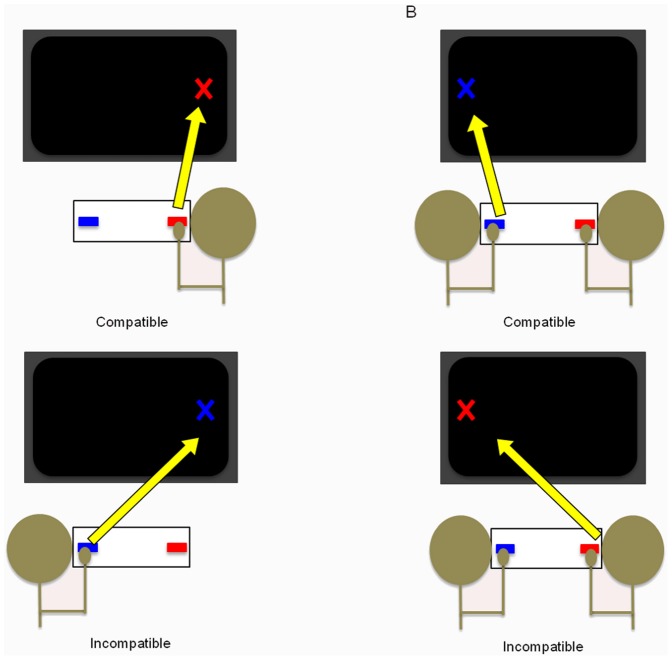
Experimental setup for (A) the individual condition, and (B) the joint condition.